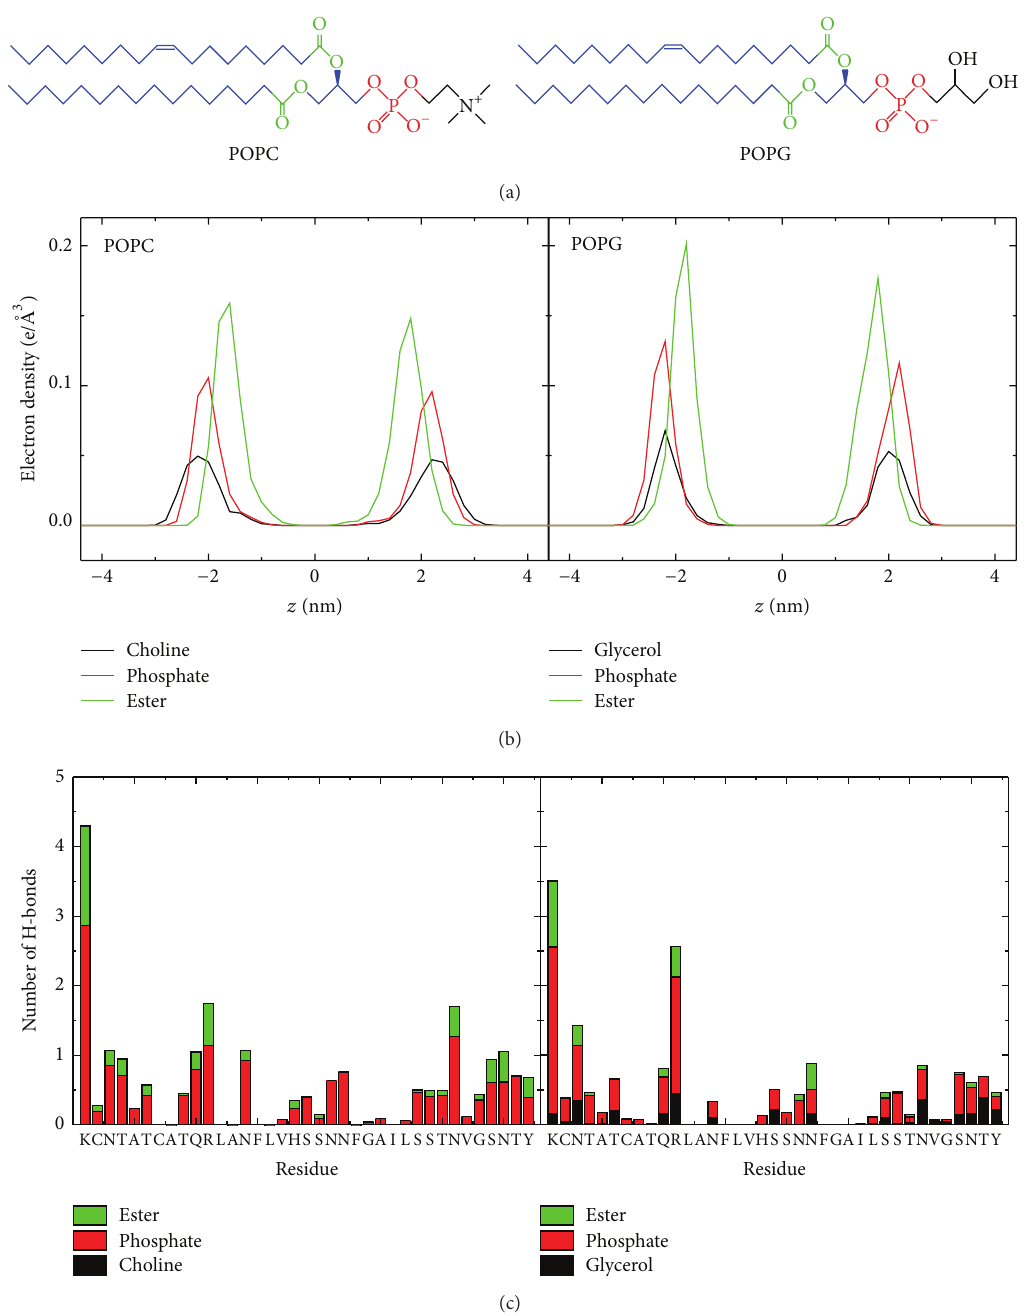
Figure 7: (a) Molecular structures of a POPC/POPG lipid molecule. Different lipid groups are colored differently: choline/glycerol in black, phosphate group in red, ester group in green, and other carbon atoms in blue. (b) Electron density profiles of the lipid choline/glycerol, phosphate, and ester groups. Here, we set the 𝑧 -position of bilayer at zero ( 𝑧 = 0 ). (c) Number of H-bonds formed between each amino residue of hIAPP and the three different groups in lipid heads: choline (POPC)/glycerol (POPG), phosphate, and ester groups.